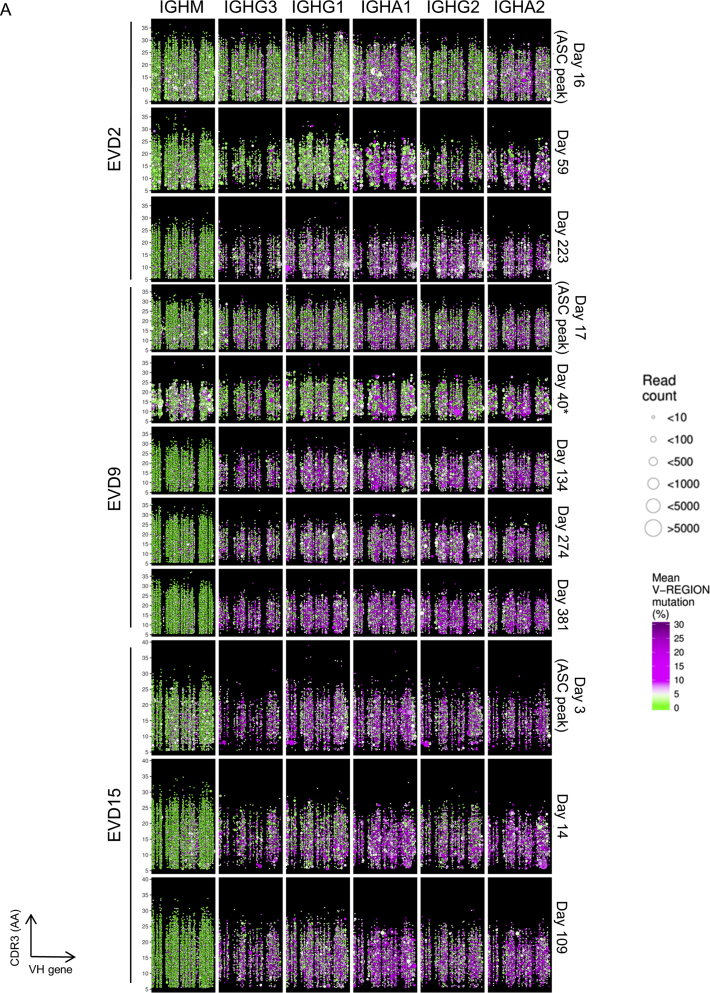
Overview of Antibody Repertoire at Various Time Points for EVD2, EVD9, and EVD15, Related to Figure 2Each B cell lineage is represented as a point in the plot. The position of each point represents the clone’s isotype (column), time point (row), IGHV usage (x axis) and CDR3 length (y axis). Sizes indicate the number of unique reads grouped into the clone. Colors indicate the mean SHM% for the clone. Points are jittered to prevent some over-plotting of clones with the same V and CDR3 lengths. Time points indicate the number of days elapsed since symptom onset. Note, RNA for EVD9 day 40 (marked with an asterisk) was extracted from magnetically-sorted ASCs, while RNA for the other time points came from total PBMCs.